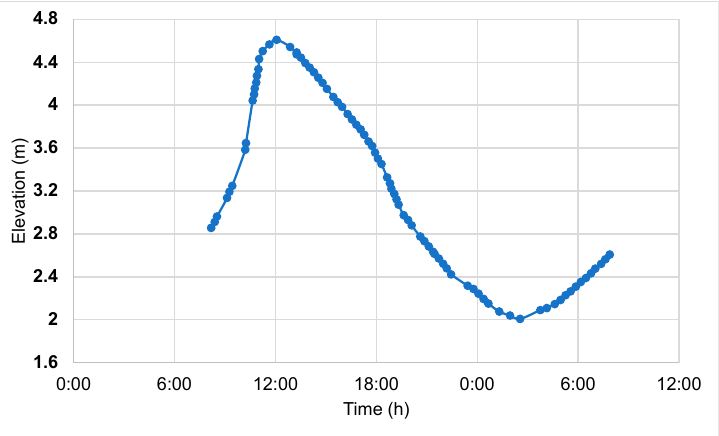
Figure 4. The water level at the mouth of the P-8 channel.